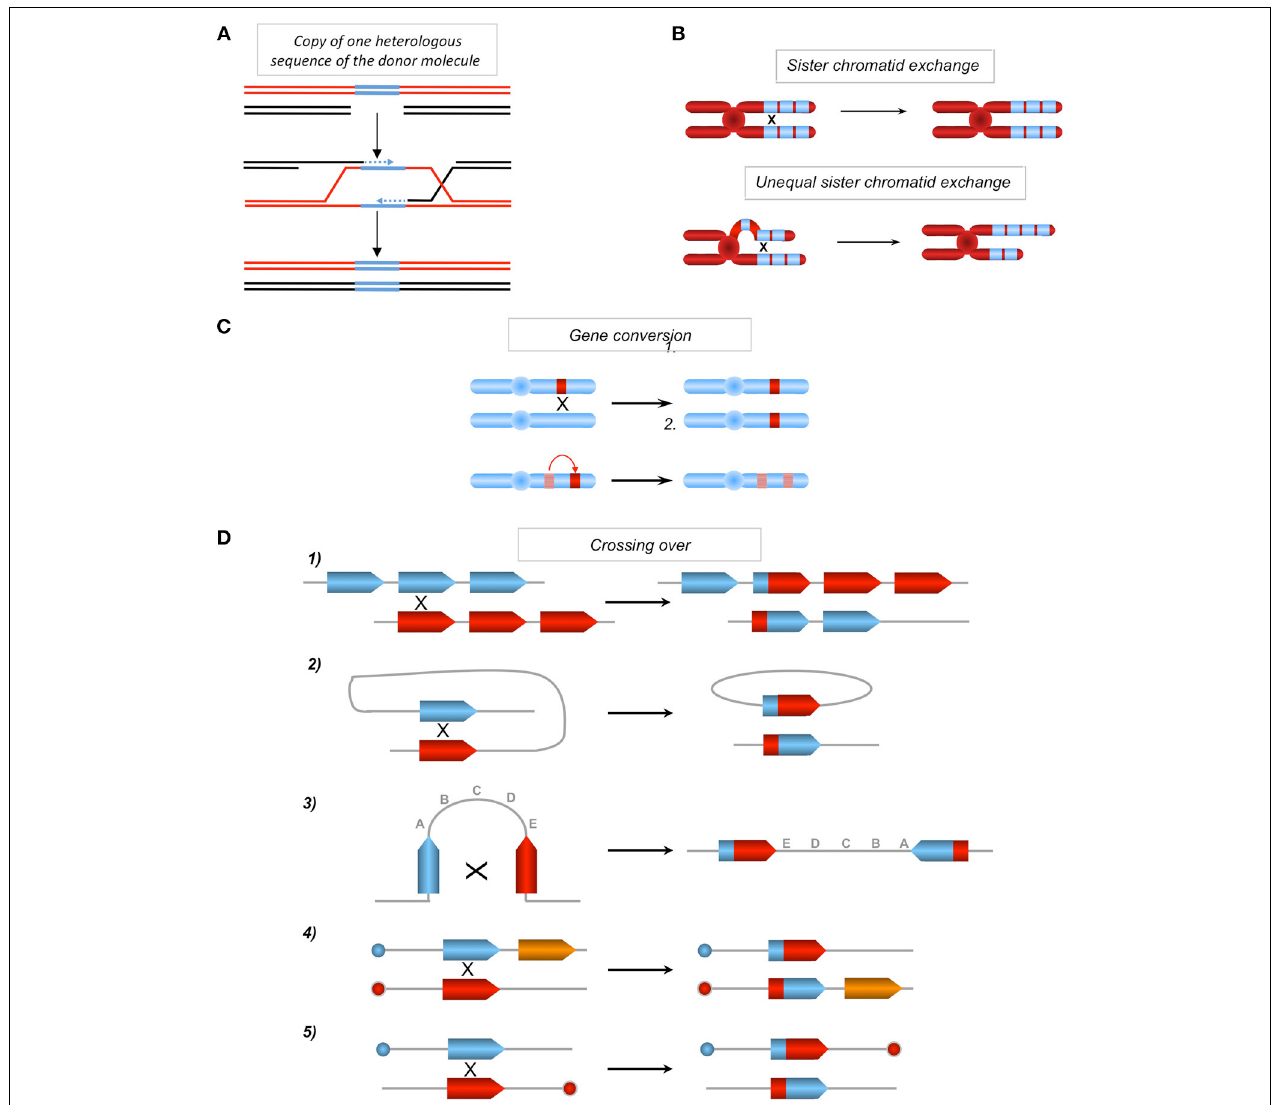
FIGURE 3 | (A) Copy of one sequence of the donor absent on the recipient molecule. One of two homologous molecules (red and black) can contain one heterologous sequence (blue). Upon gene conversion or SDSA (see Figure 1 ) the heterologous (blue) sequence can be copied and transferred from the donor sequence (red) to the homologous recipient sequence (black), resulting in a genetic modification of the recipient sequence. (B) Sister chromatid exchanges. Between repeat sequences (blue boxes) without misalignment (upper panel) or with misalignment resulting in unequal sister chromatid exchanges (lower panel) and amplification and loss of genetic material. (C) Impact of gene conversion. Non-reciprocal exchange of genetic information between two heteroalleles, leading to a loss of heterozygosity (upper panel) and between a pseudogene (hatched), which often contains nonsense